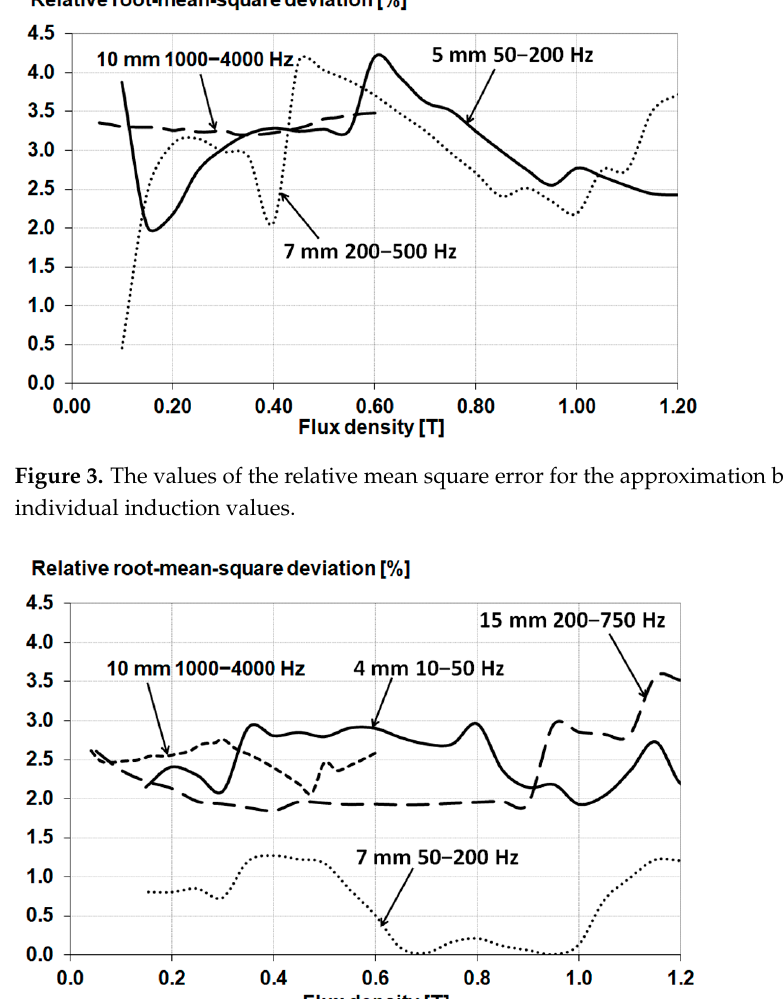
Figure 4. Values of the relative mean square error for approximation with a linear function for individual induction values for laser-cut samples.